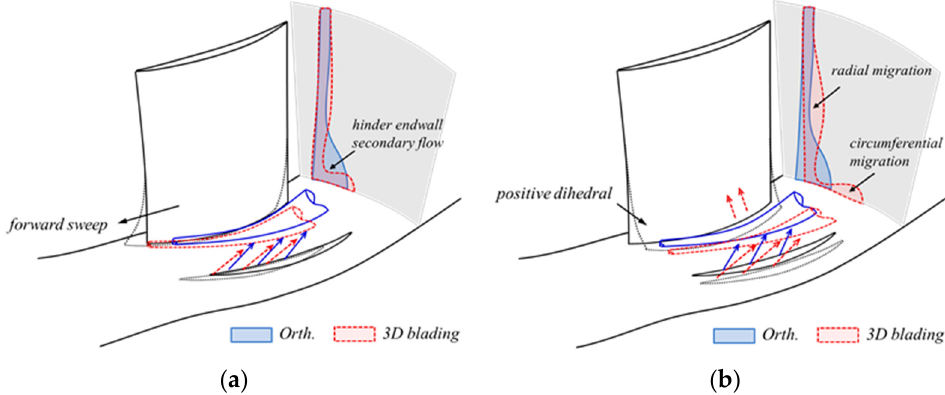
Figure 24. The mechanisms of sweep and dihedral on the cantilevered stator: ( a ) sweep; ( b ) dihedral.